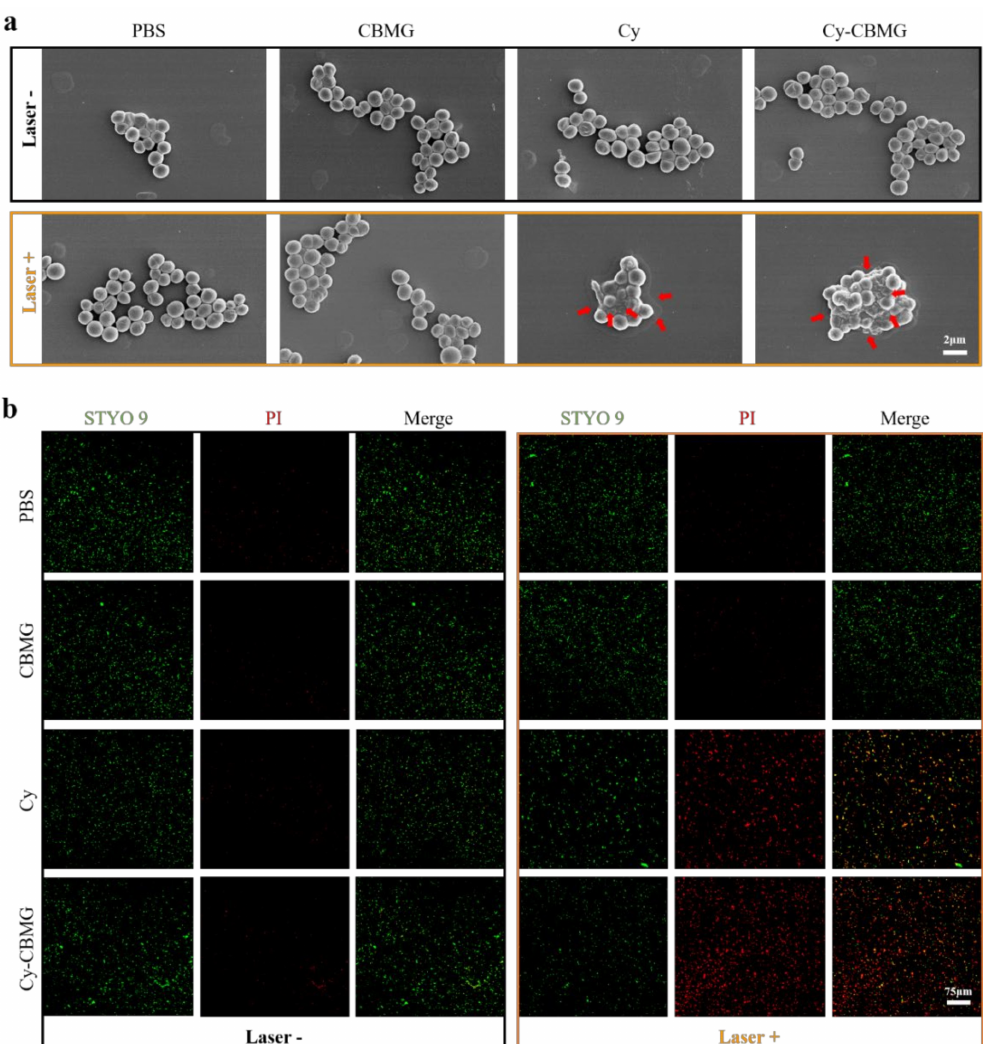
Figure 4. Morphological changes of MRSA after various treatments. ( a ) Representative SEM pho- tographs of MRSA after various treatments. Red arrows indicated MRSA bacteria with damaged membranes. ( b ) Confocal images of MRSA bacteria with Live/Dead staining. Green signal: live cells. Red signal: dead cells. PI: propidium